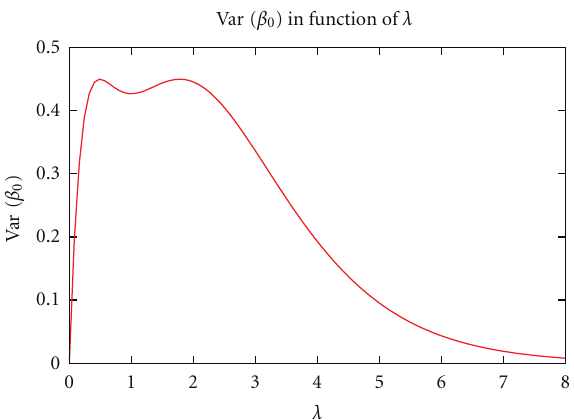
Figure 6: Behavior of the variance of the number of clusters in function of λ when L (cid:6) 4 and (cid:4) (cid:6) 1. Pr ( β 0 = n ) in function of λ